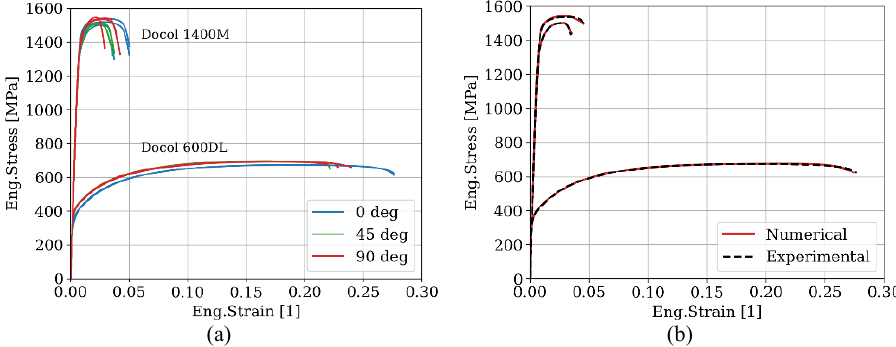
Fig. 1. Engineering stress-strain curves for Docol 600DL and Docol 1400M: (a) experimental curves and (b) numerical results applying the fitted material parameters in the